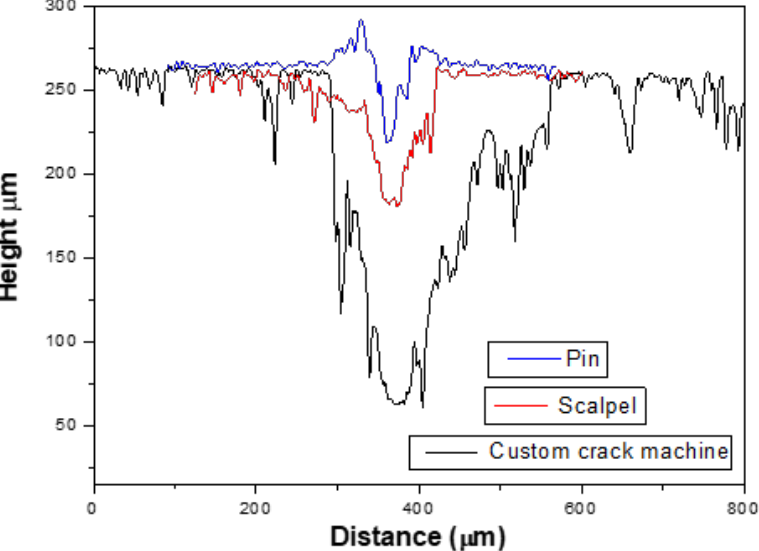
Figure 12. Profile image generated by the three tools used (custom crack machine, scalpel, and pin) in the surface of the PCL/epoxy blends showing the different geometries of the cracks. In sum, the results proved that the self-healing efficiency in the PCL/epoxy blend was quite significantly affected by the PCL content, healing temperature, and crack geometry.